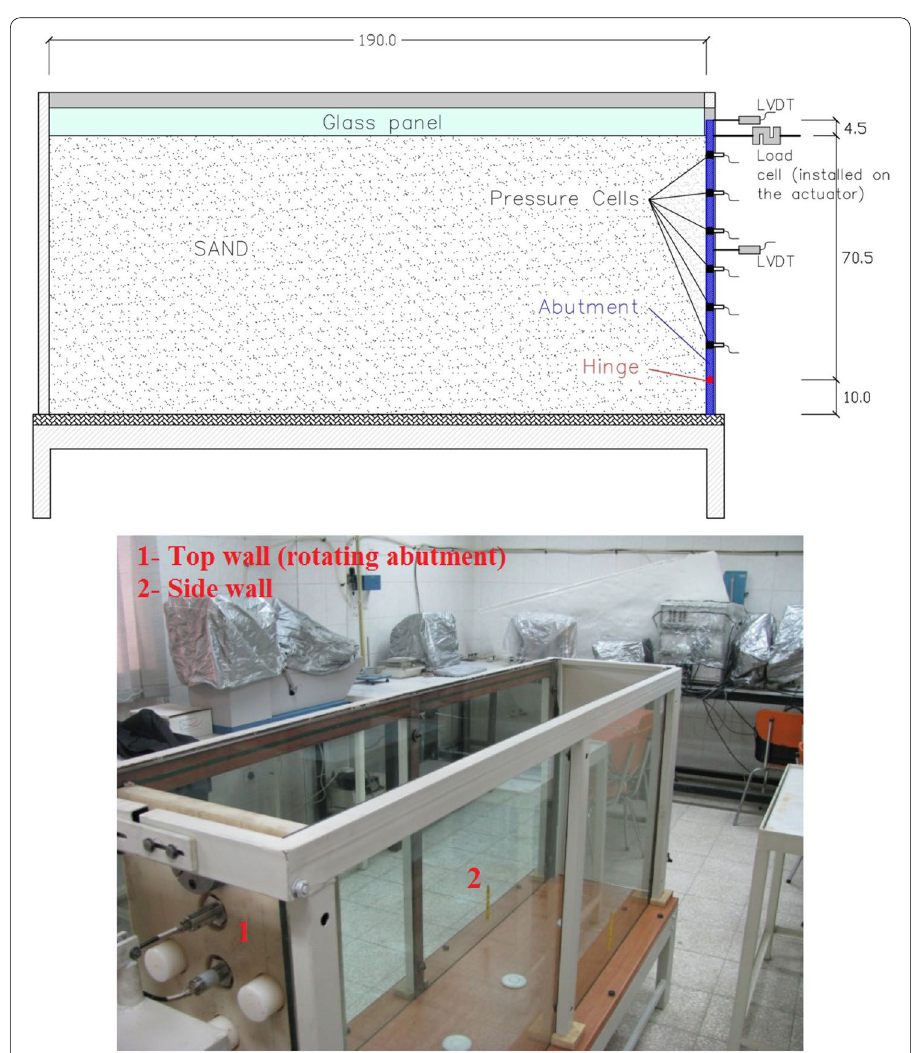
from the surface. Also, active shear zones are observable with the help of colored sand